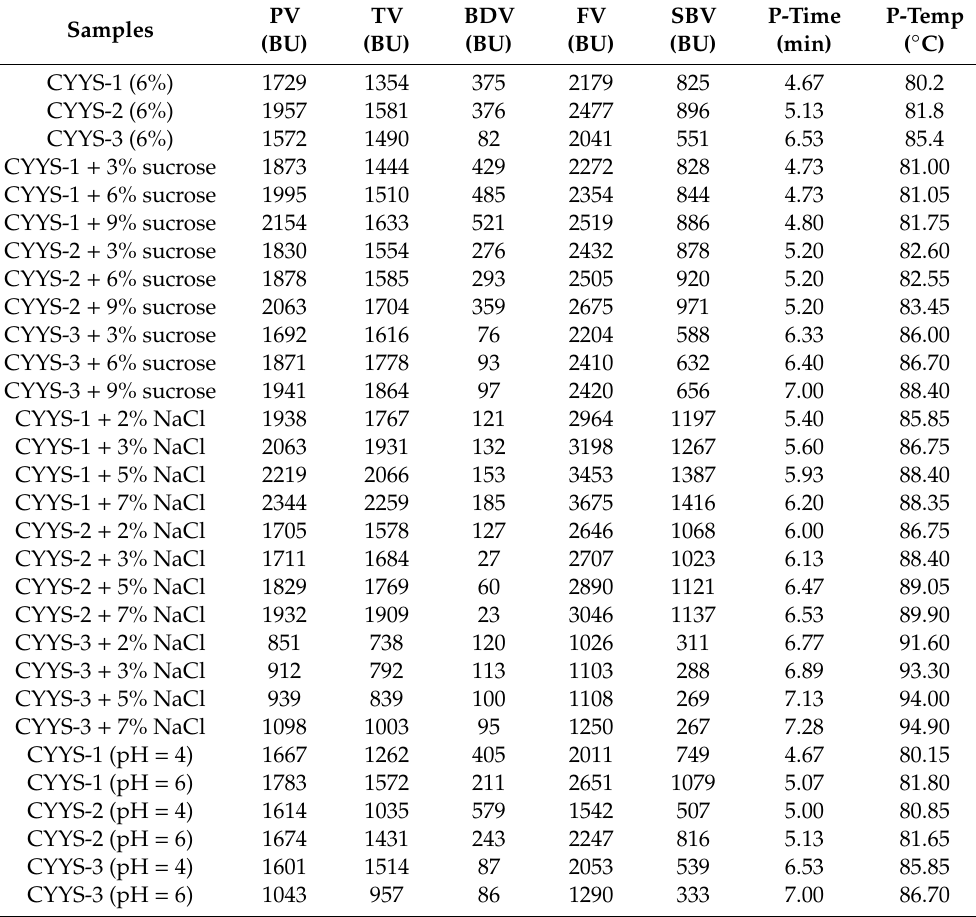
Table 4. The RVA parameters of CYYS-1, CYYS-2 and CYYS-3 A